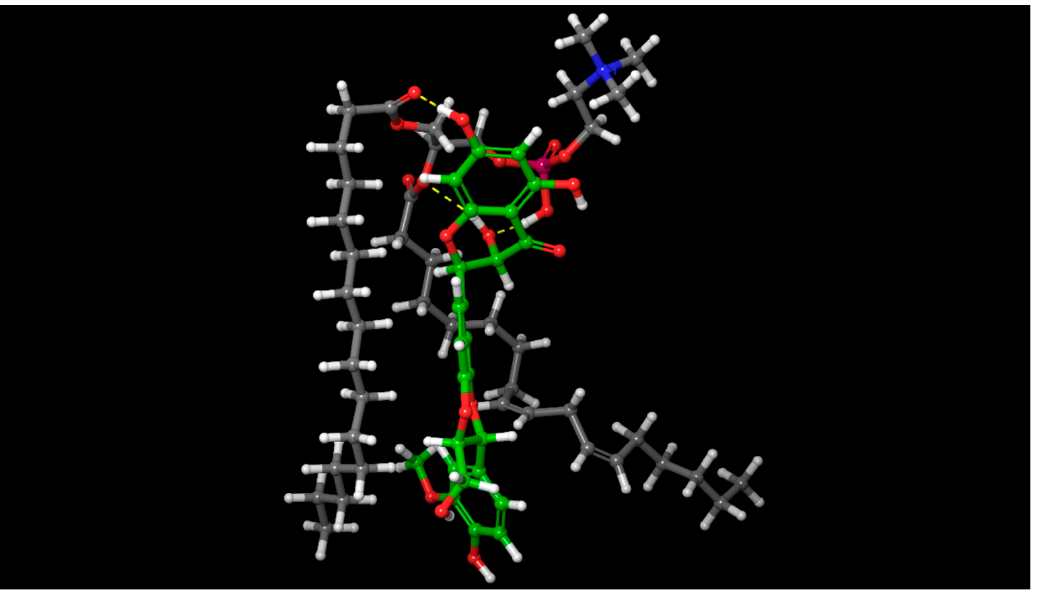
Figure 8. Interaction bonds and binding observed with SIL–SPC complex; Blue: Aromatic hydrogen bonds; Yellow: Hydrogen bonds; Purple: Halogen bonds.